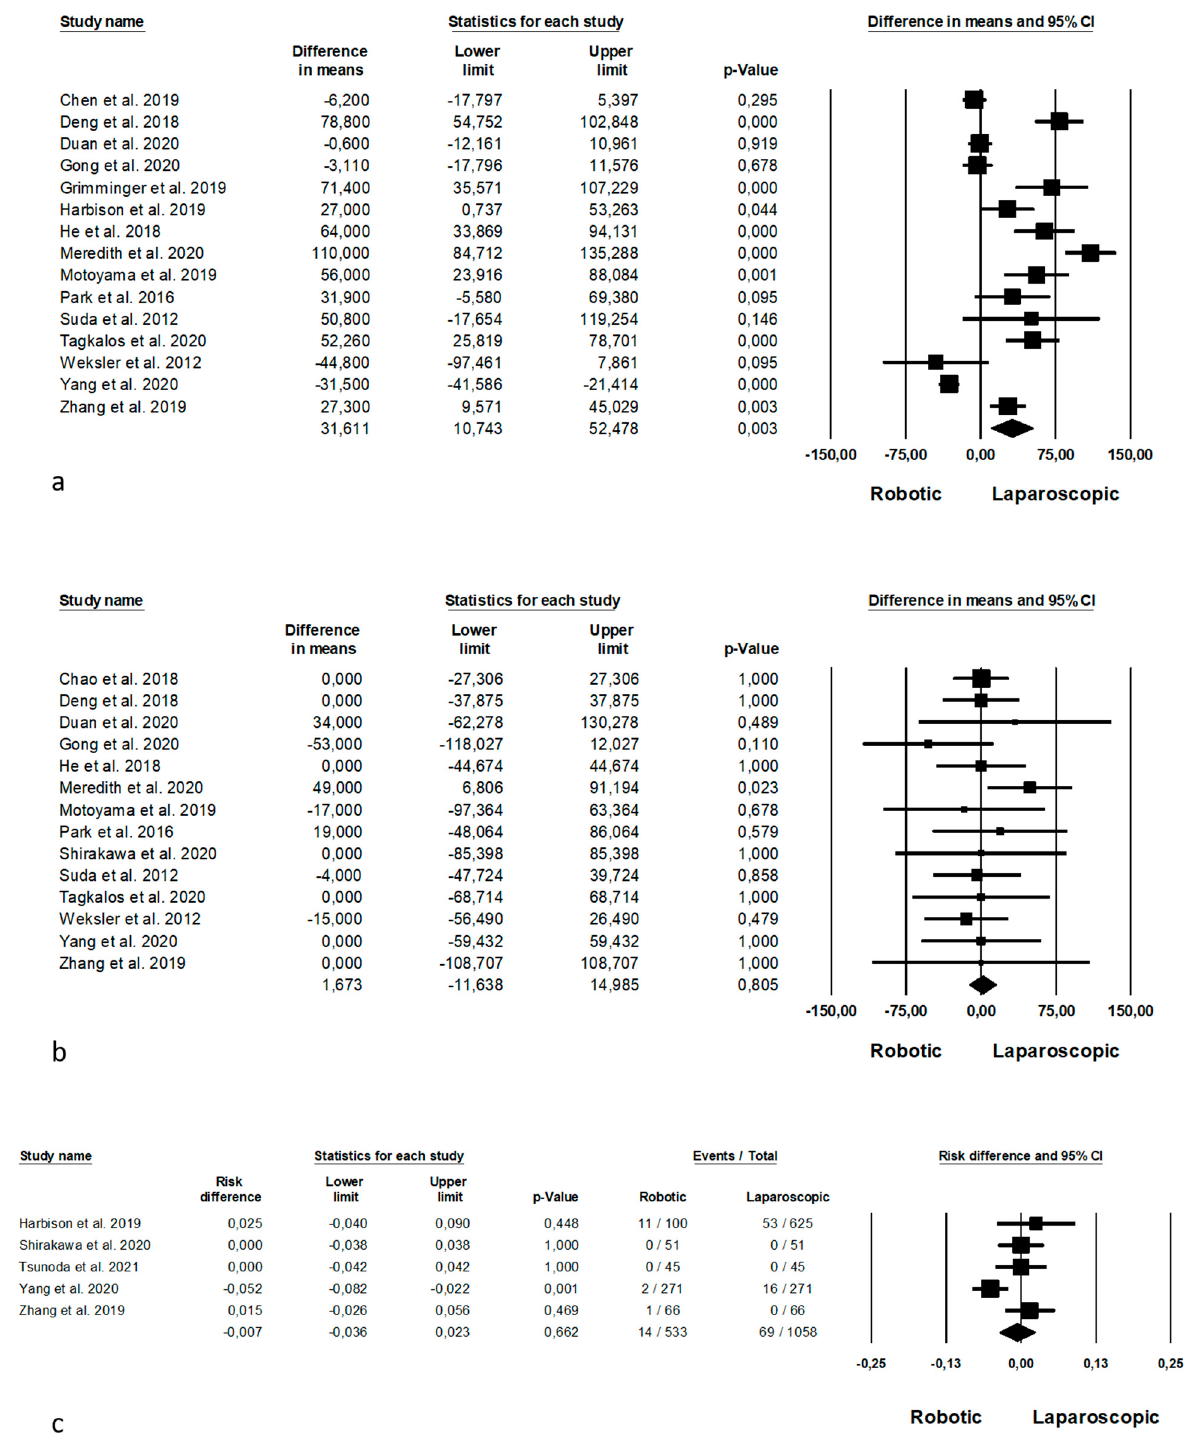
Figure 2. Robotic versus laparoscopic surgery: intraoperative outcomes. ( a ) operative time; ( b ) estimated blood loss; ( c ) conversion.